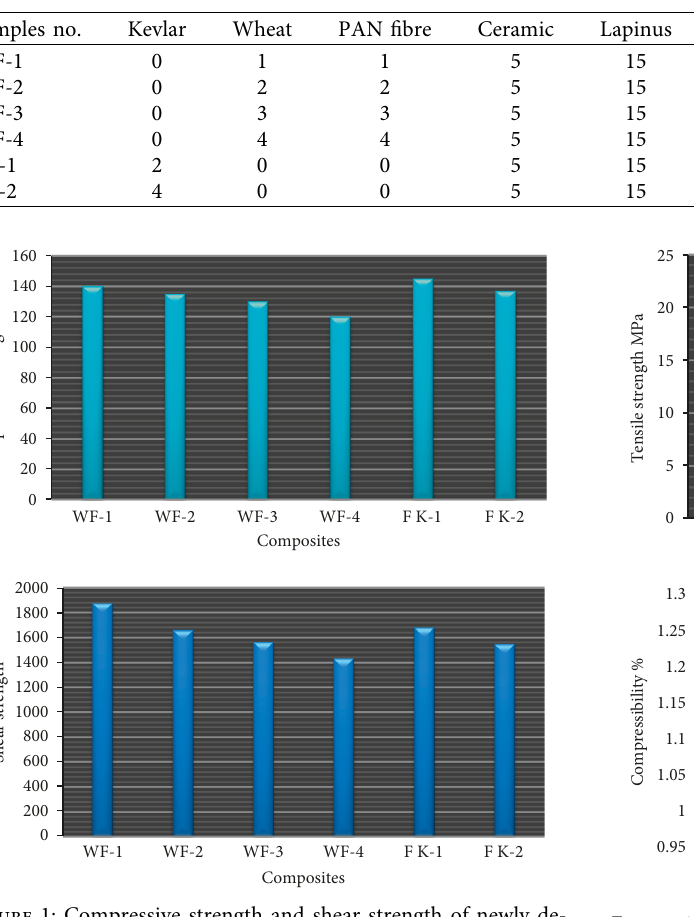
Table 2: Compositional details of materials.